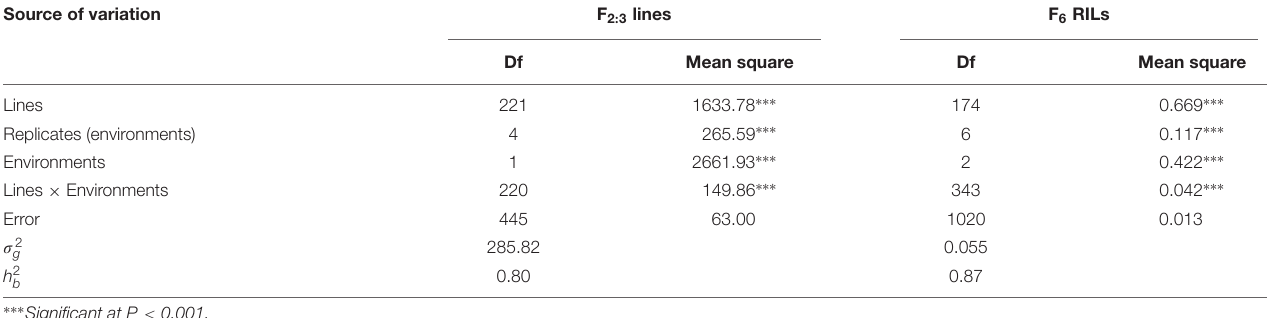
TABLE 2 | Variance components of MDS scores for F 2 : 3 lines and rAUDPC for F 6 recombinant inbred line population derived from AvS/Napo 63. Source of variation